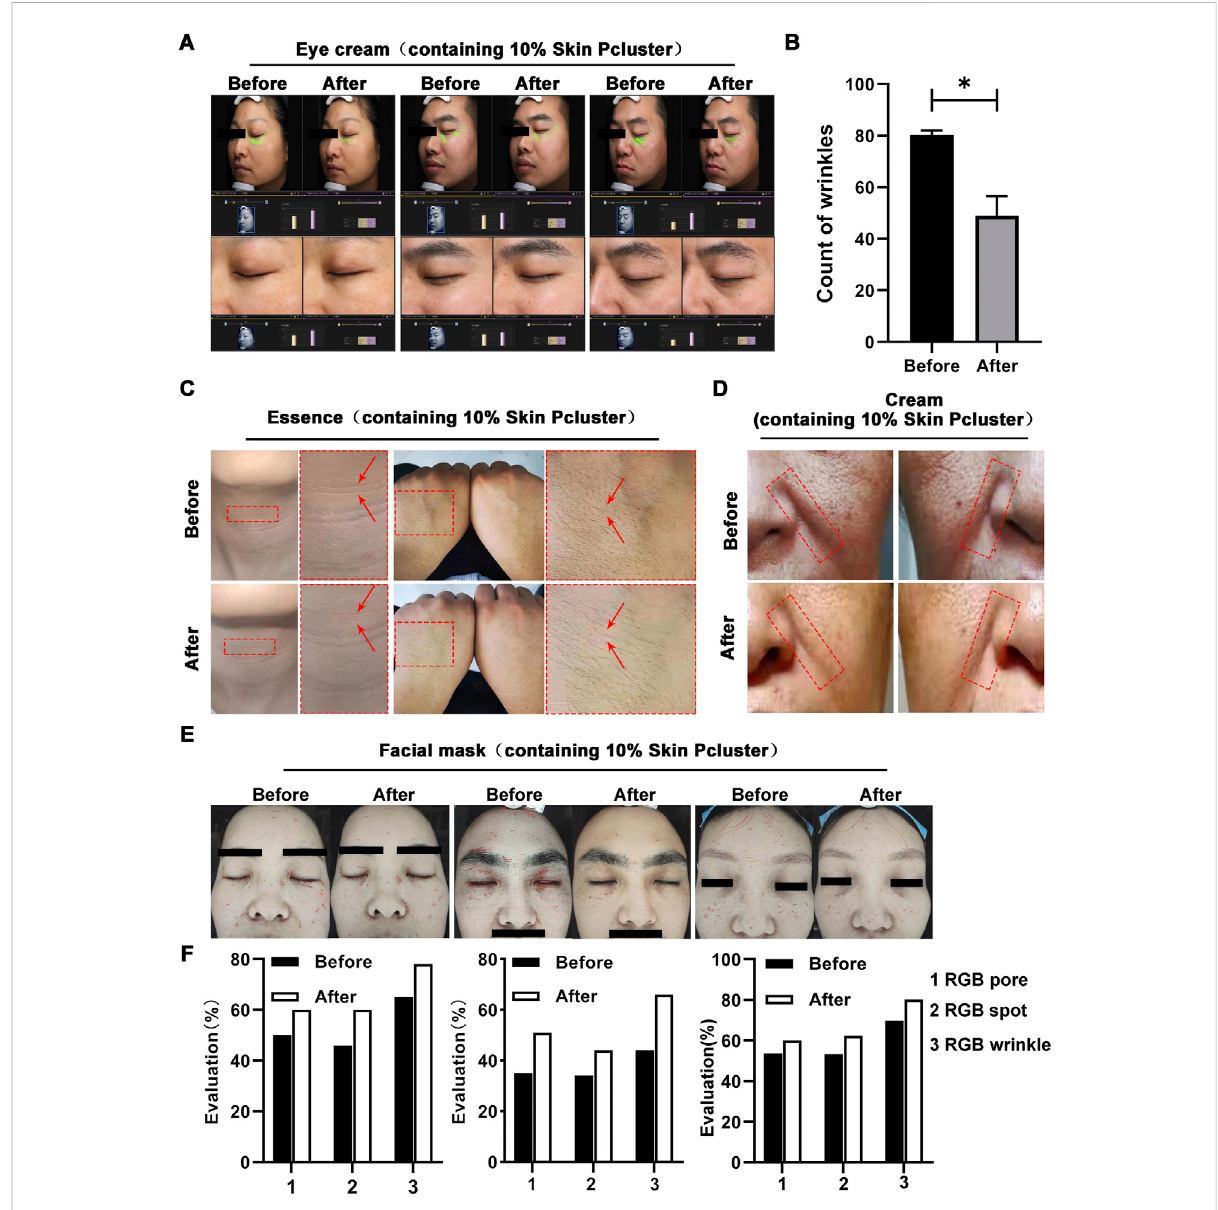
FIGURE 5 Anti-wrinkle effectofSkinPclusterinhumans. (A , B) Beforeandafterthetreatmentwitheyecream(including 10%SkinPcluster),VISIAwasused to visualize the wrinkles around the eyes of the recruited volunteers. The number of wrinkles was quanti fi ed. (C) The representative photographs of healthy subjects ’ neck and hand before and after treatment with essence containing 10% Skin Pcluster. (D) Images of facial wrinkles treated with a cream containing 10%Skin Pcluster. (E , F) Images ofwrinkles around theeyesand ontheforeheadoftherecruited volunteerswereobtained by VISIA before and after treatment with eye cream containing 10% Skin Pcluster. p values were obtained by t